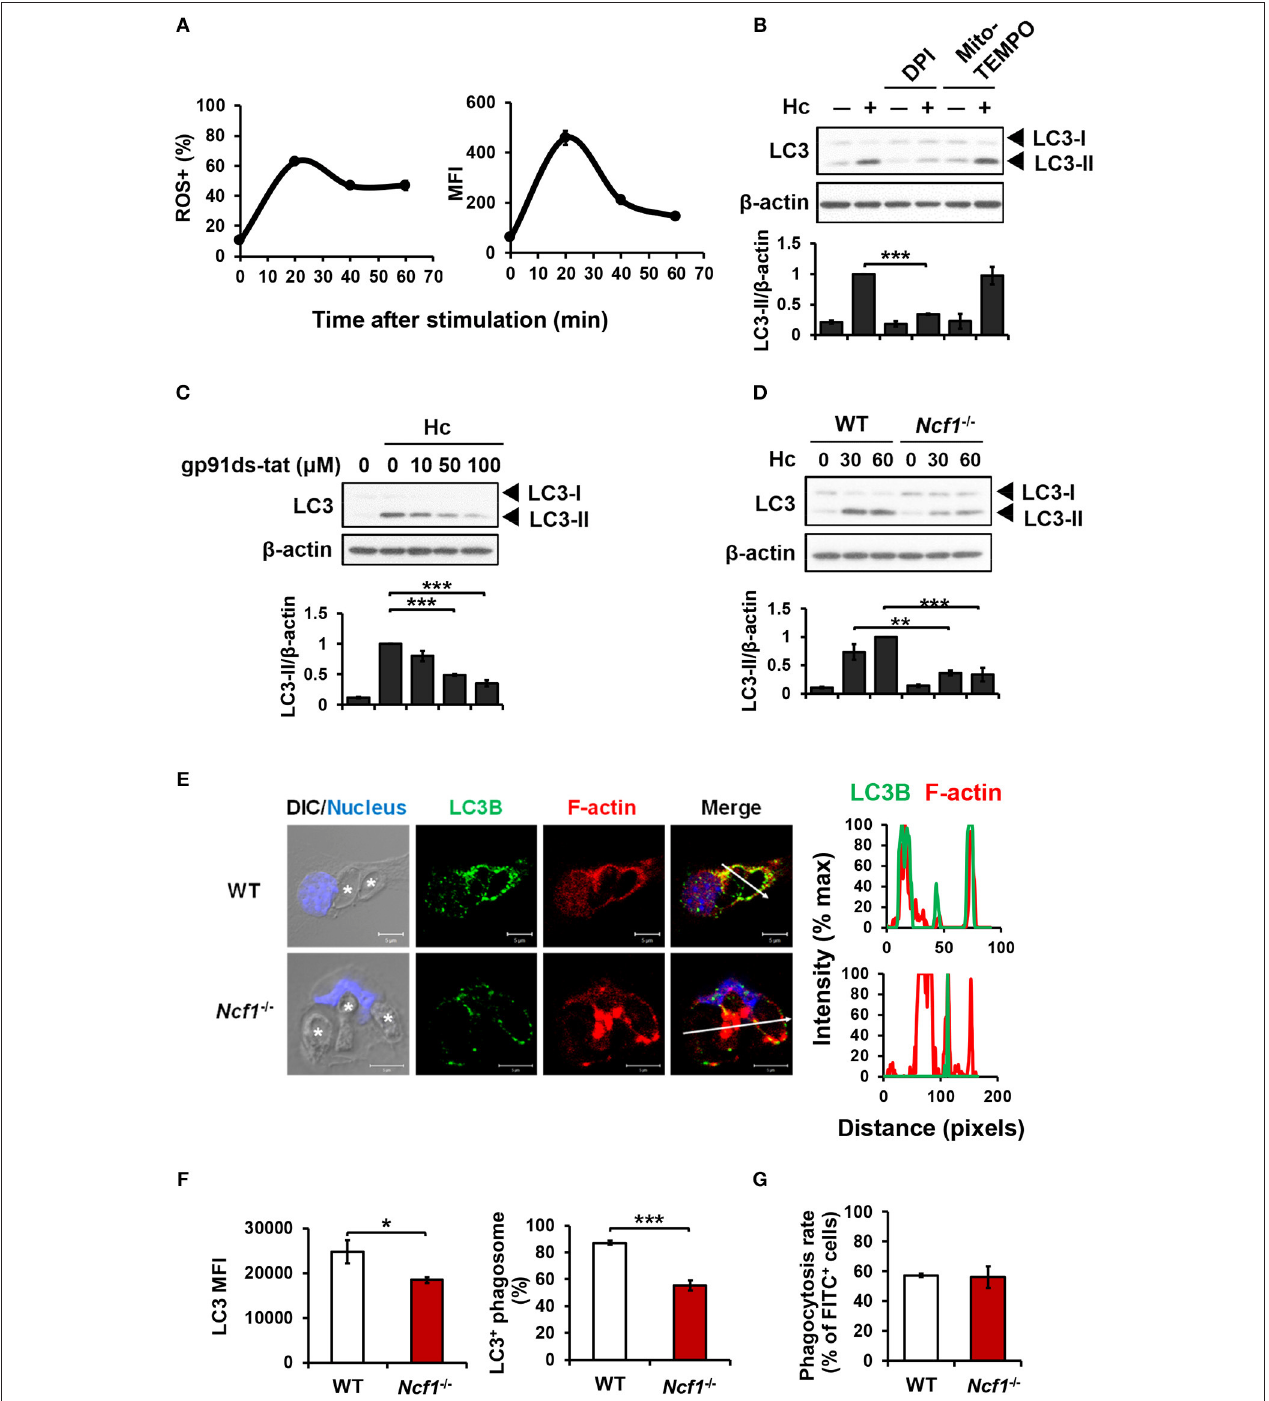
FIGURE 3 | NADPH oxidase-mediated ROS response to H. capsulatum is essential for LC3 conversion in macrophages. (A) Macrophages from WT mice were preloaded with CM-H 2 DCFDA for 30min prior to stimulation with H. capsulatum (MOI = 10) for indicated time. Flow cytometry was performed to assess global ROS production. Data shown are the percentages of ROS + cells (left panel) and the mean fluorescence intensity (MFI) (right panel) of total live cells. Mean ± SEM are shown ( n = 4). (B,C) Macrophages from WT mice were treated with or without DPI (5 µ M), Mito-Tempo (10 µ M) (B) , and gp91ds-tat (10, 50, and 100 µ M) (C) for 1h prior to stimulation with H. capsulatum (MOI = 5). Cell lysates were collected after 1h of stimulation and analyzed by Western blotting. (D) Macrophages from WT or Ncf1 − / − mice were stimulated with or without (0min) H. capsulatum (MOI = 5) for 30 and 60min. Cell lysates were subjected to Western blotting. Data shown in the lower panel are relative intensity of LC3-II normalized against the corresponding β -actin; mean ± SEM are shown. [ n = 3 for (B,C) ; n = 4 for (D) ]. (E,F)